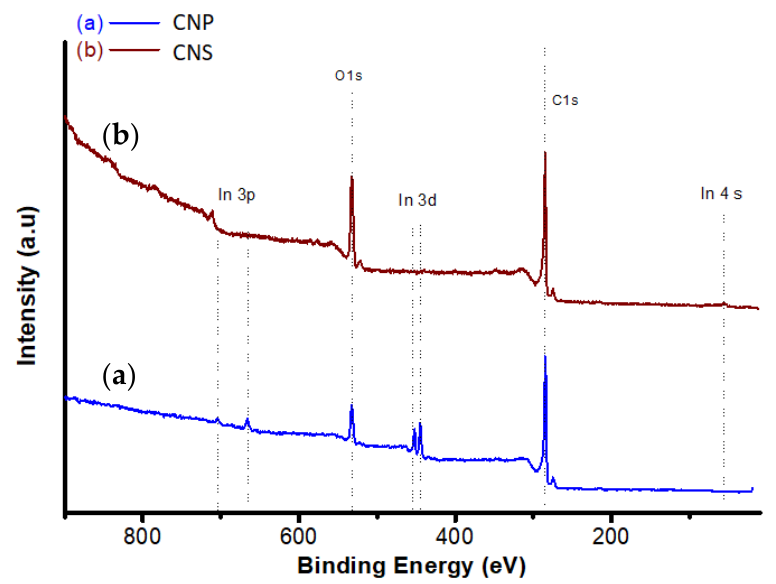
Figure 5. XPS analysis for ( a ) CNP and ( b ) CNS with 40 eV pass energy and 0.3 s dwell time.